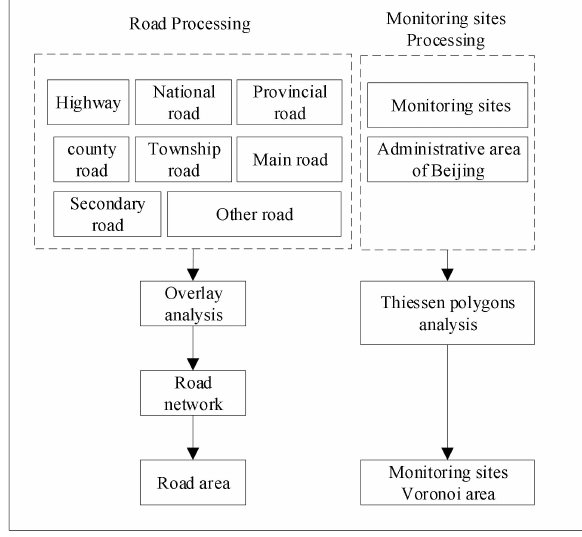
Figure 2. Data processing flow